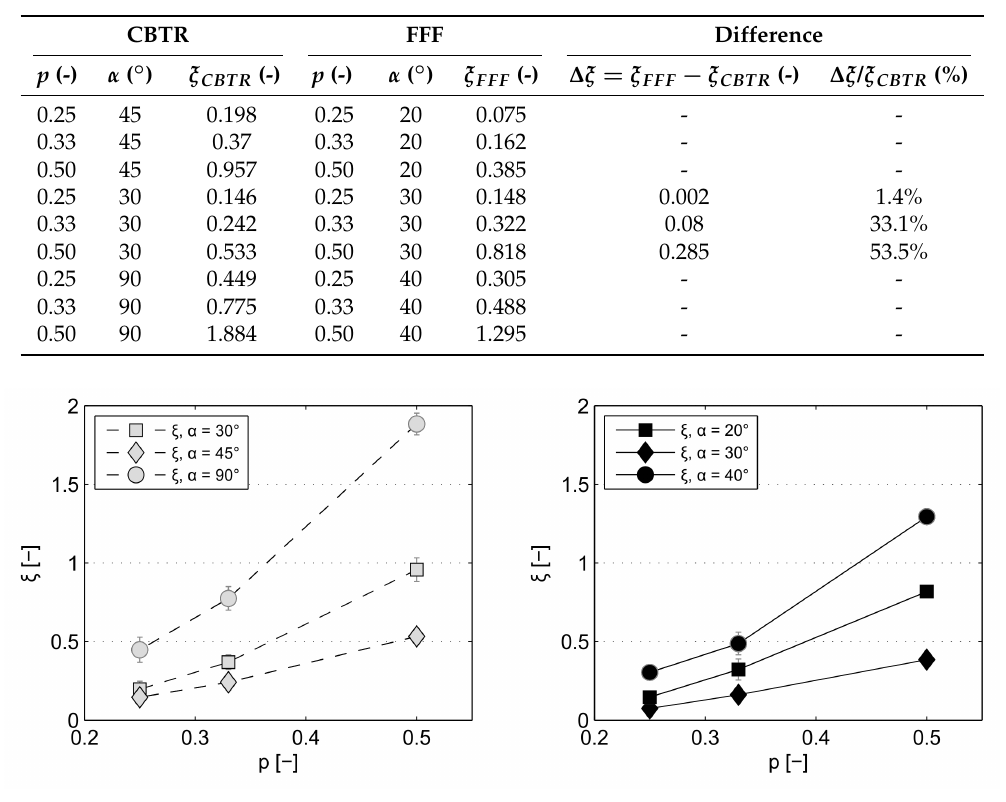
Table 3. Local head loss ξ measured for the trash rack with circular bars (CBTR) and the flexible fish fence (FFF) depending on the blockage ratio p and rack angle α —differences between the two rack options for α = 30 ◦ .